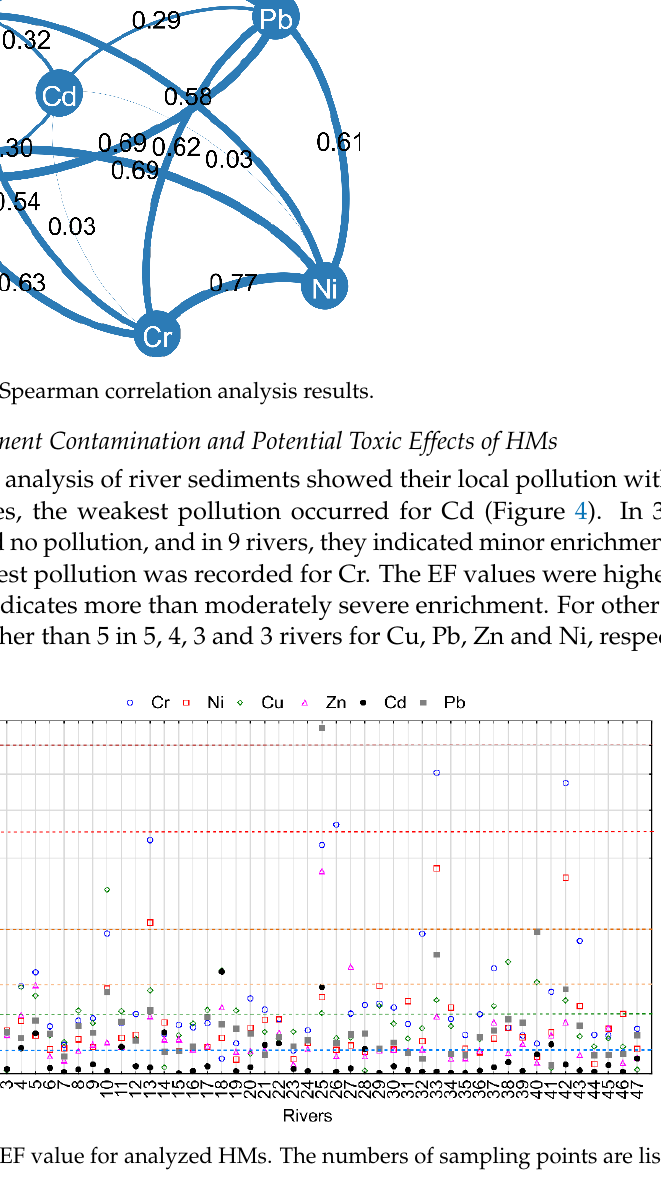
Figure 2. Violin plots showing the concentrations of individual HMs.